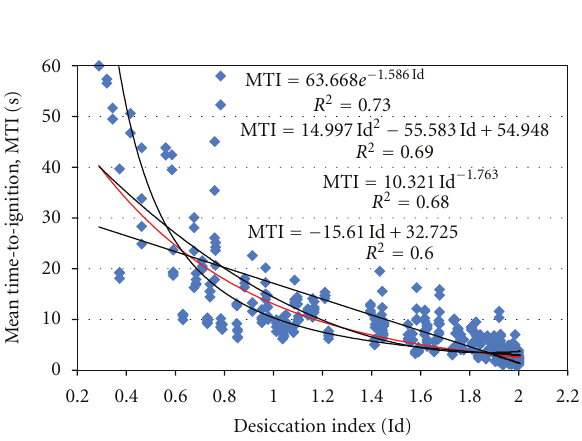
Figure 2: Mean time-to-ignition (MTI) values of Moroccan species as a function of their desiccation index